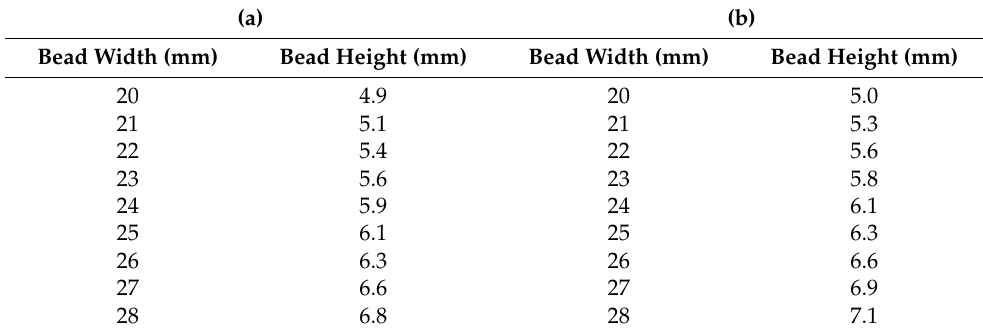
Refer to Table 11 Refer to Table 11 No restriction Table 11. Bead height and width meeting the E curve requirements of the BV rule when the angular distortion is 0.7 ◦ : (a) by Equation (4); (b) by Equation (7). (a) (b) Bead Width